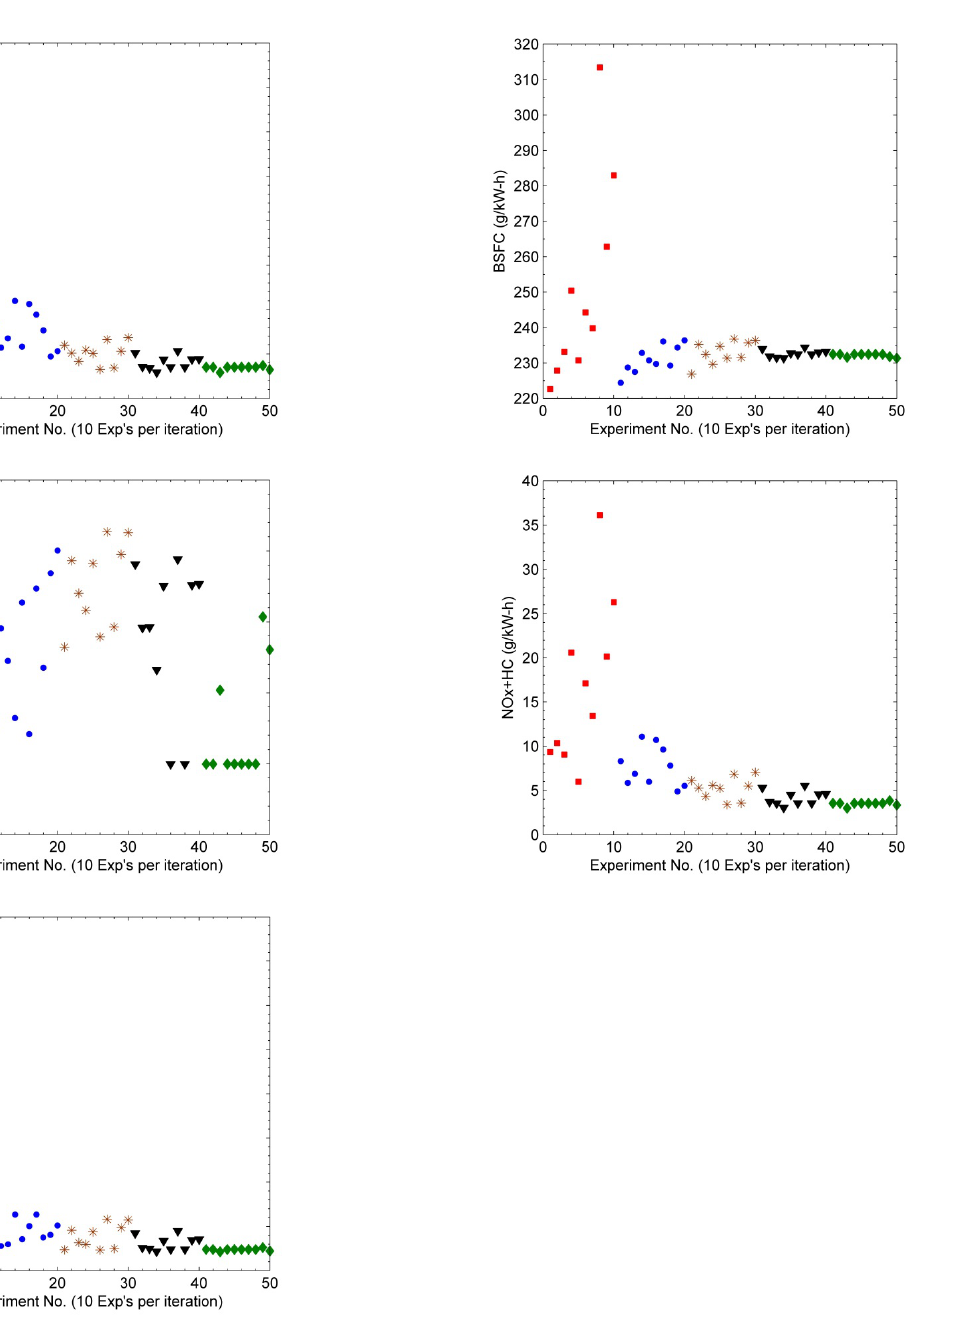
Fig. 9: Evolution of response variables optimized in this